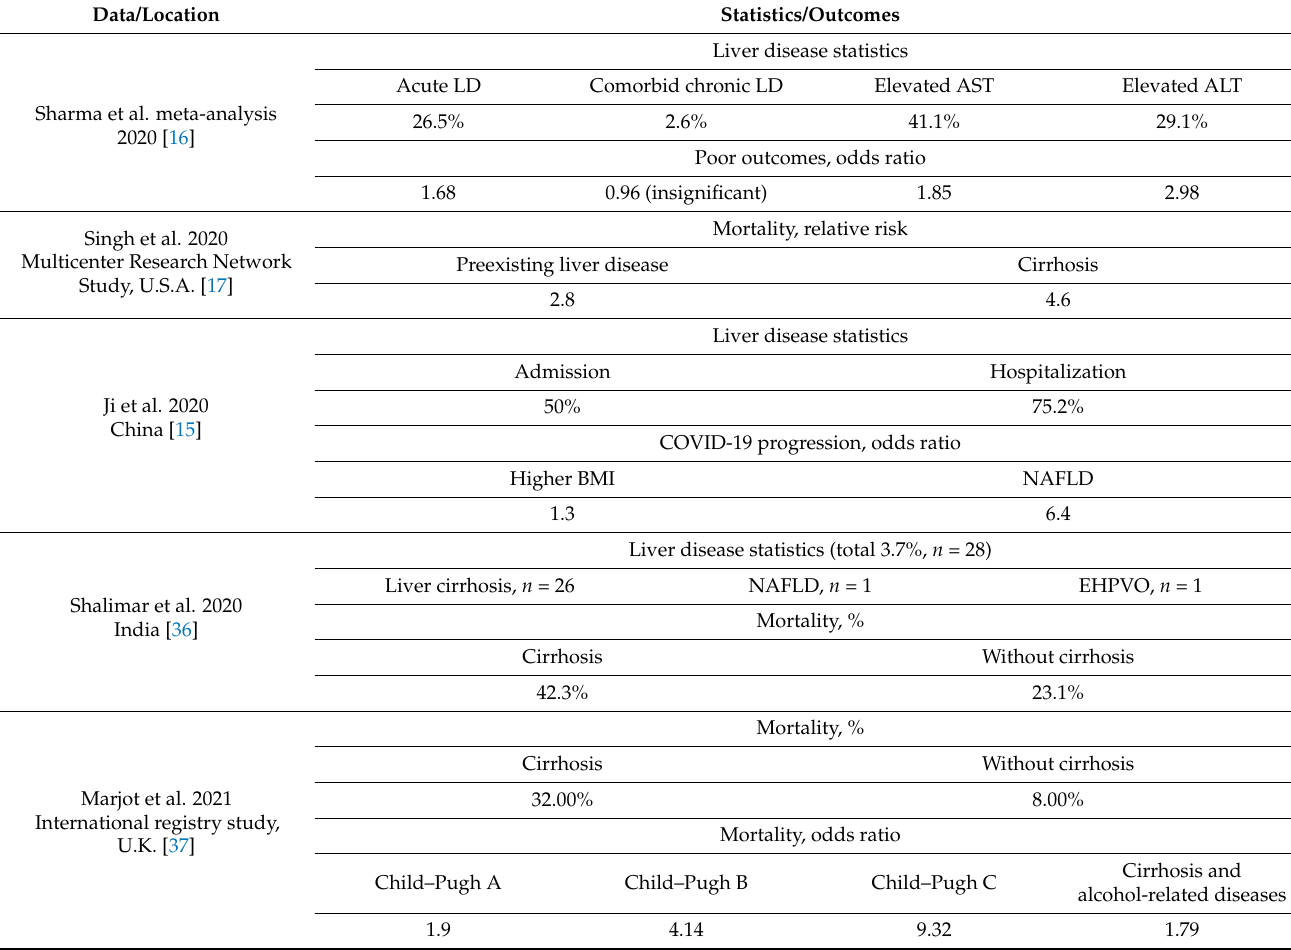
Table 1. Liver statistics and